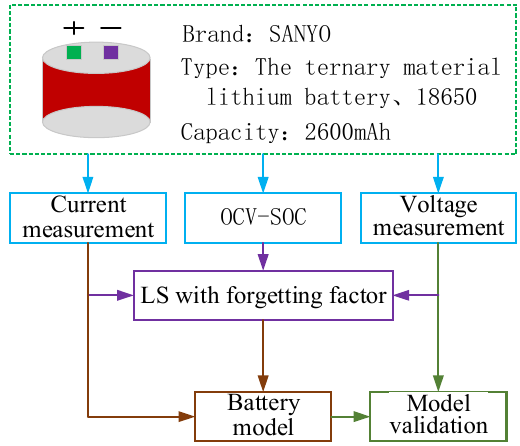
Figure 3. Parameter identification flow chart.